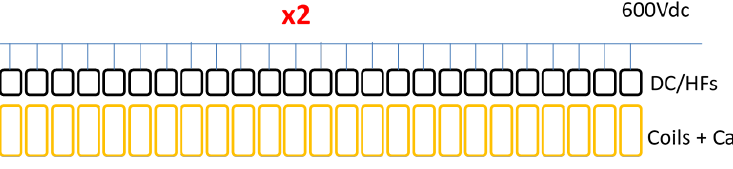
Figure 2. The layout of the Politecnico di Torino (POLITO) system at the test site.